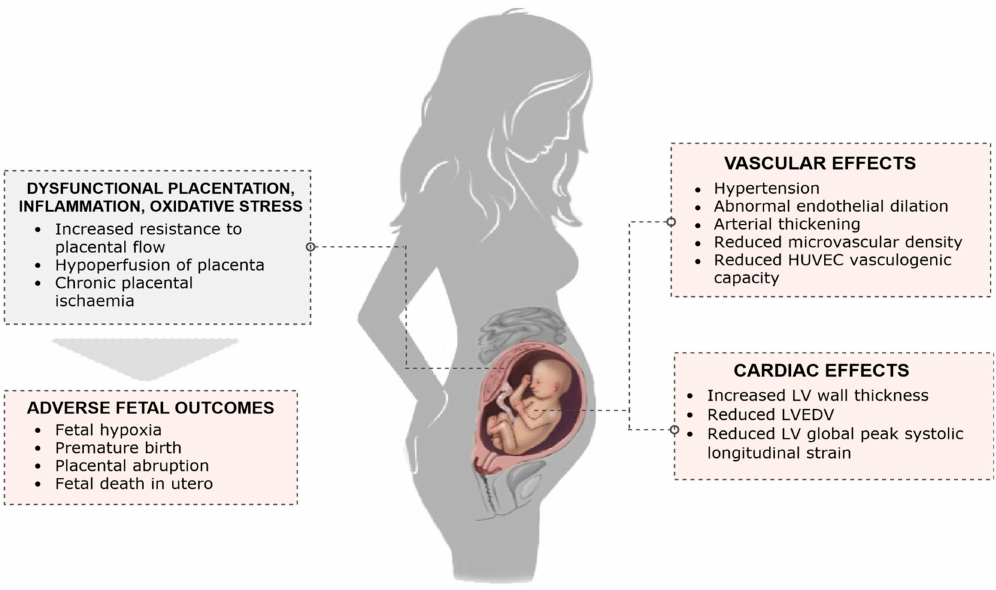
Figure 1. E ff ects of preeclampsia on the foetus and o ff spring. HUVEC stands for human umbilical vein endothelial cells; LV, left ventricle; LVEDV, left ventricular end-diastolic